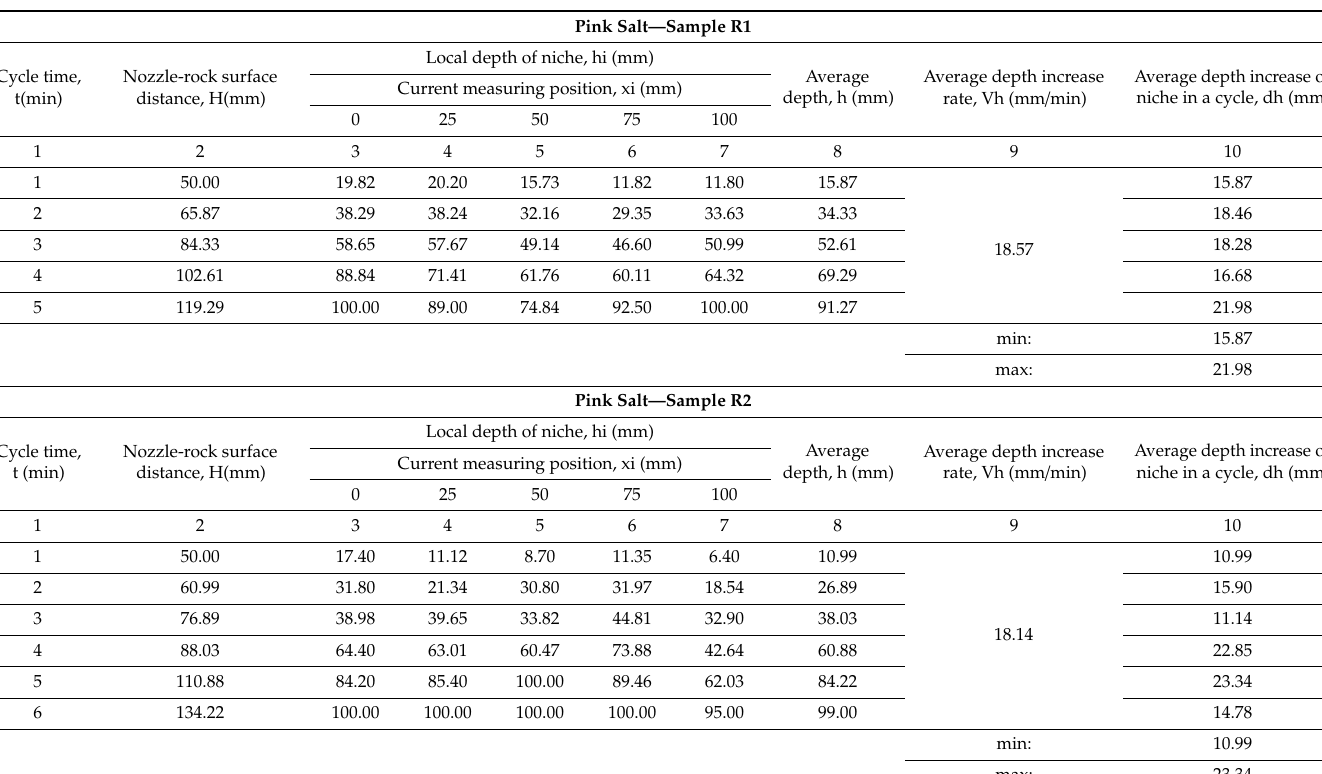
Table 5. Results of measurements of high-pressure water jet niche cutting parameters—“pink salt”